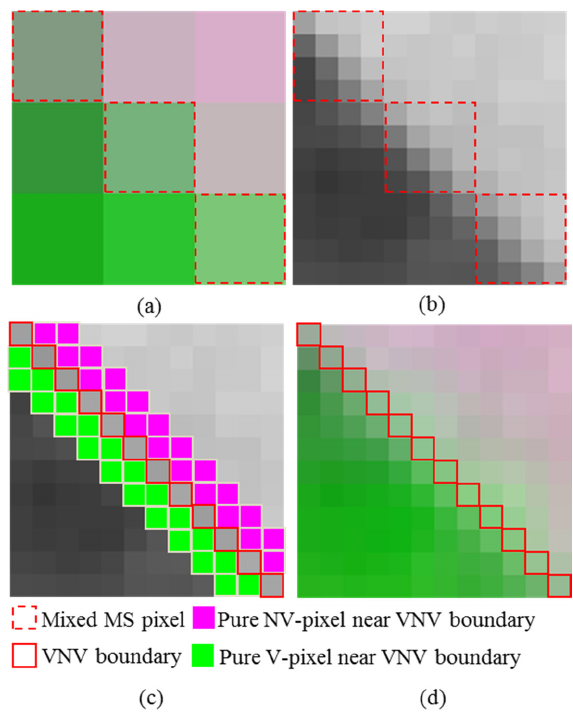
Figure 1. Mixed multispectral (MS) sub-pixels and the corresponding PAN and fused images. ( a ) The mixed MS pixels at MS resolution; ( b ) the PAN pixels corresponding to the MS pixels in ( a ); ( c ) PAN (edge) pixels across vegetation and non-vegetation (VNV) boundaries and pure PAN (V and NV) pixels near the VNV boundaries; ( d ) Gram–Schmidt (GS)-fused image overlain with VNV boundaries from the PAN image.